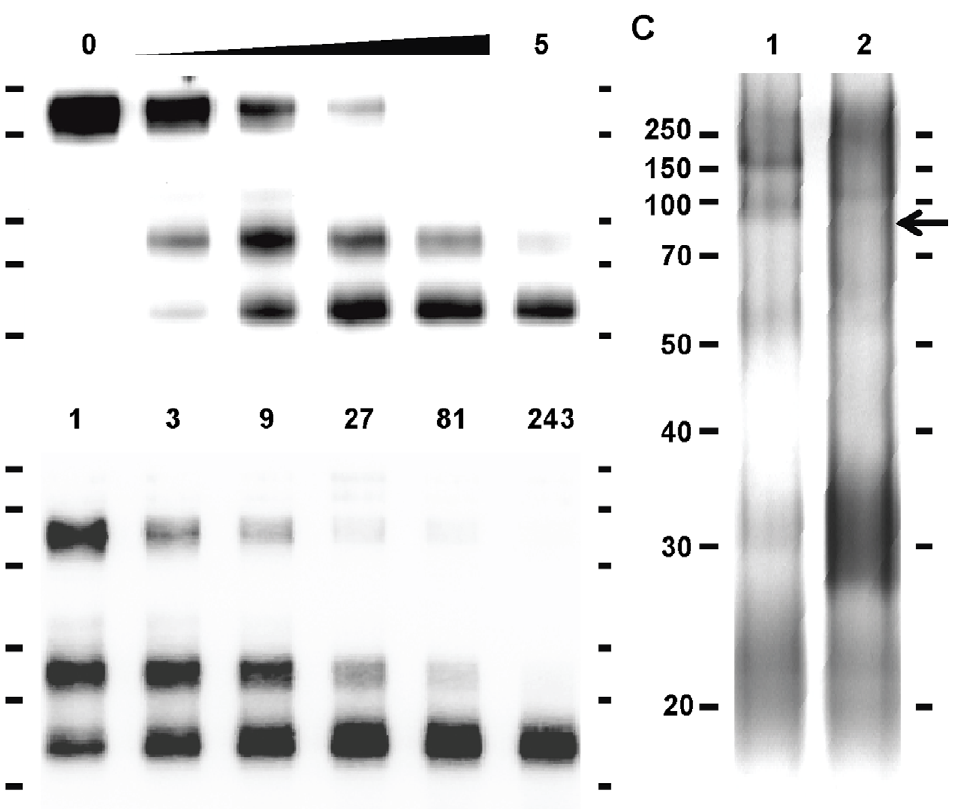
Figure 1. MMP-9 Cleaves SP-D in a Dose- and Time-dependent Manner. (A) Dose and (B) time course digestions of SP-D by MMP-9. For the dose course (A), the reaction loaded onto lane 2 contained 62 ng/mL MMP-9 and the concentration was raised 3-fold serially to 5 m g/mL MMP-9 at lane 6. Reactions were incubated for 4 hours. For the time course (B), the length of digestion in minutes is listed above the lane. SP-D concentration was 20 m g/mL for both experiments, and MMP-9 concentration was 5 m g/mL for the time course. For the Native PAGE (C), lane 1 contains intact SP-D and lane 2 contains cleaved SP-D. An arrow indicates the band corresponding to MMP-9.